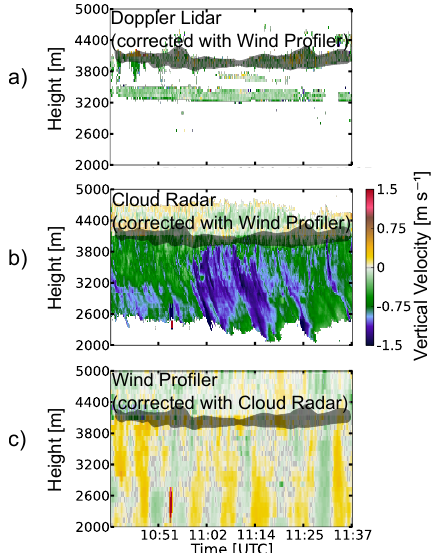
Figure 10. Demonstration of mutual vertical-velocity correction of the measurement shown in Fig. 8. A nearest-neighbor interpolation of the wind-profiler data was subtracted from the cloud-radar and Doppler lidar vertical velocities. The Doppler lidar is used to iden- tify liquid layers (gray area). Inside and above these layers the sub- traction procedure might be invalid because of several effects in- cluding liquid attenuation and small-scale turbulence that cannot be resolved by the wind